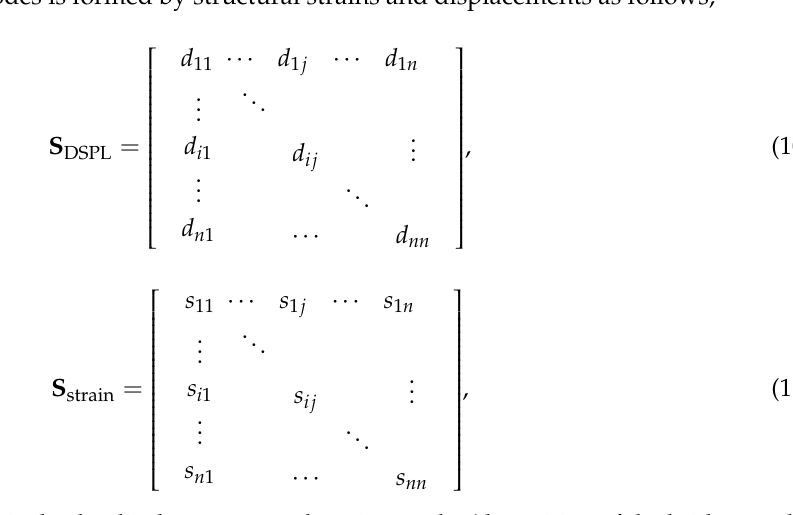
Figure 5. The E j, norm -F j and M-K statistic curves.